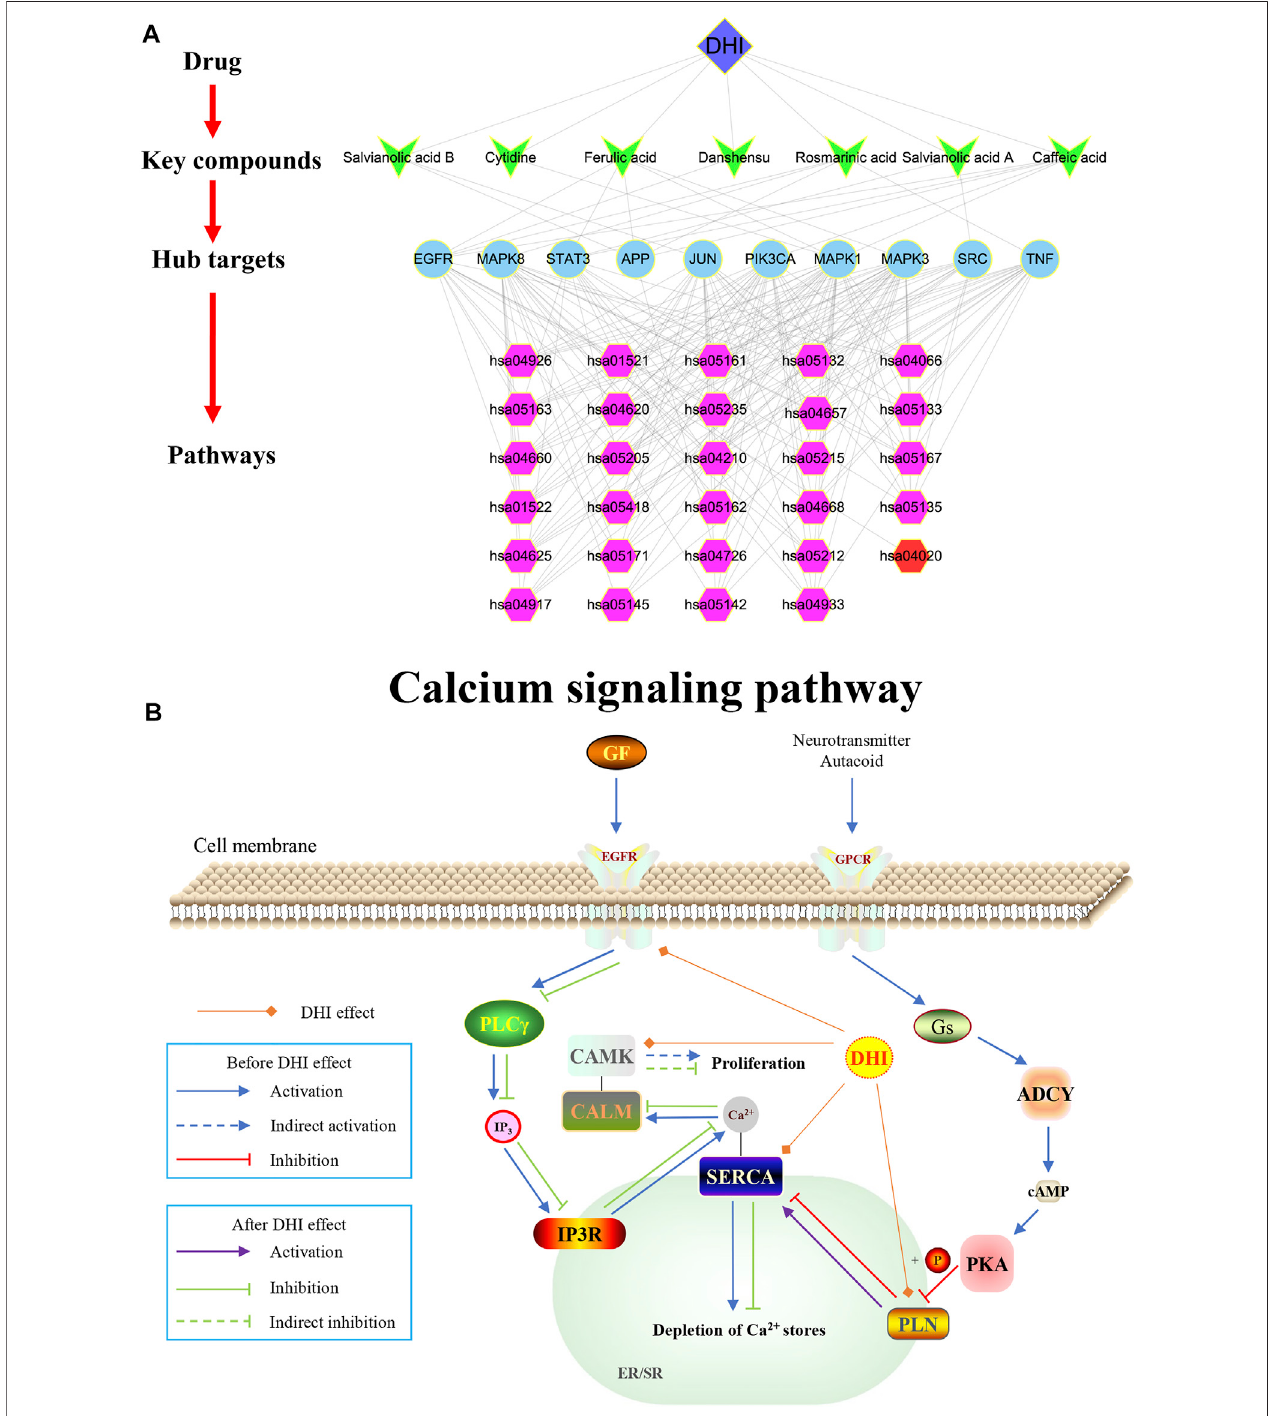
FIGURE 7 | (A) DHI-key compound-key target-pathway network. The blue diamond represents DHI; Cyan V-type represents the key compound; the light blue circle represents the key target; the purple hexagon represents the pathways enriched by key targets; the red hexagon represents the calcium signaling pathway. (B) Schematic diagram of the calcium signaling pathway